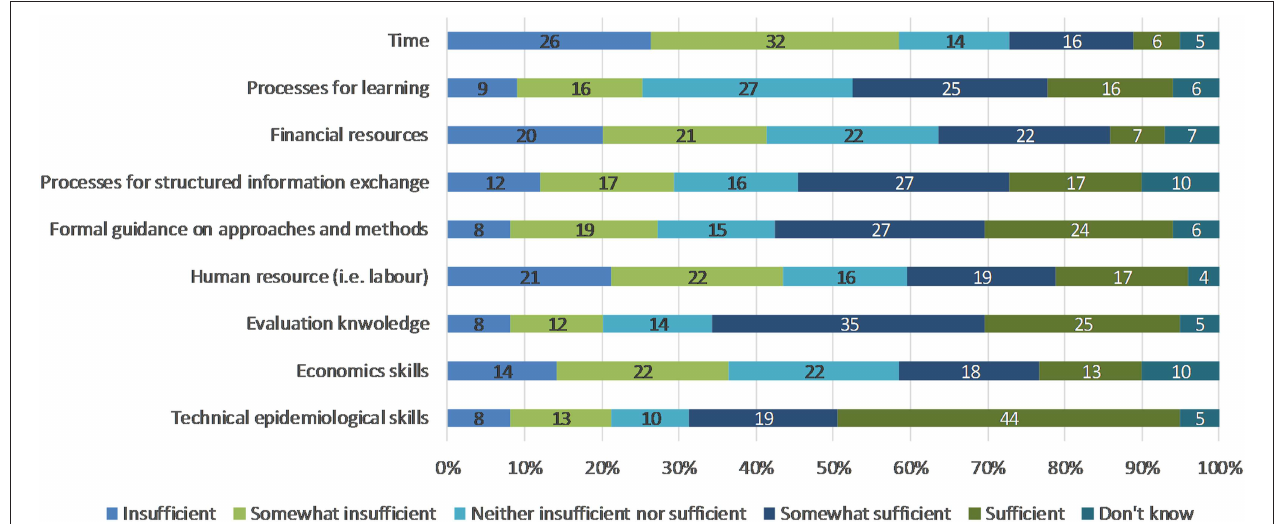
FIGURE 4 | Respondents’ rating of the availability of resources for the adoption of new surveillance standards in their